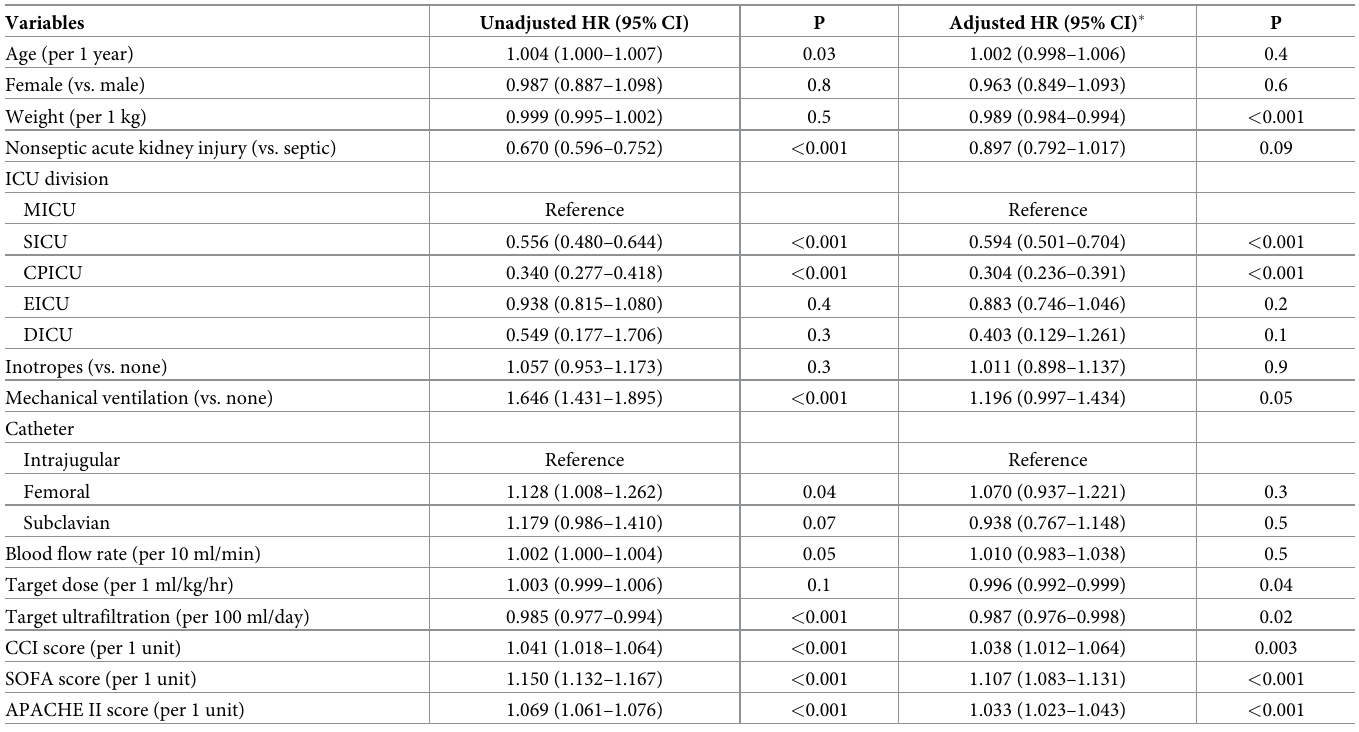
Table 2. Risk factors related to all-cause mortality.